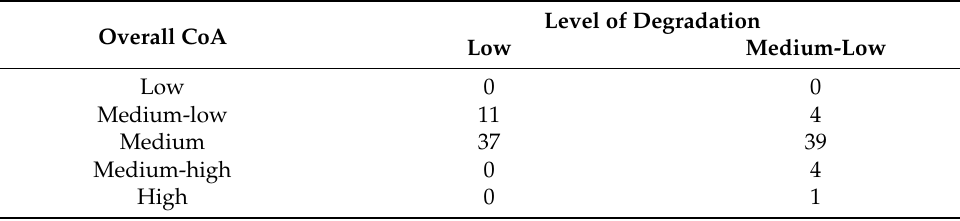
Table 6. Overall CoA result as a function of the level of degradation. Level of Degradation Overall CoA Low Medium-Low Low 0 0 Medium-low 11 4 Medium 37 39 Medium-high 0 4 High 0